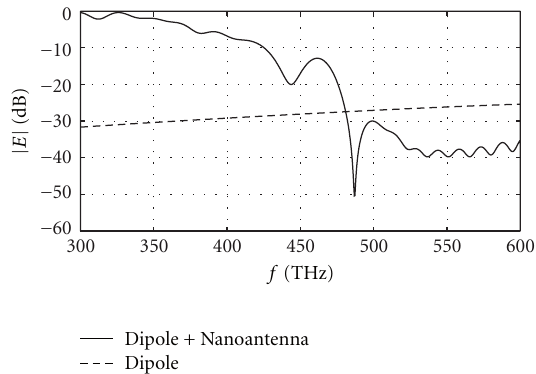
Figure 7: Comparison of the amplitude of the radiated Ex electric field taken 1 mm above the material interface (see Figure 6(b)).